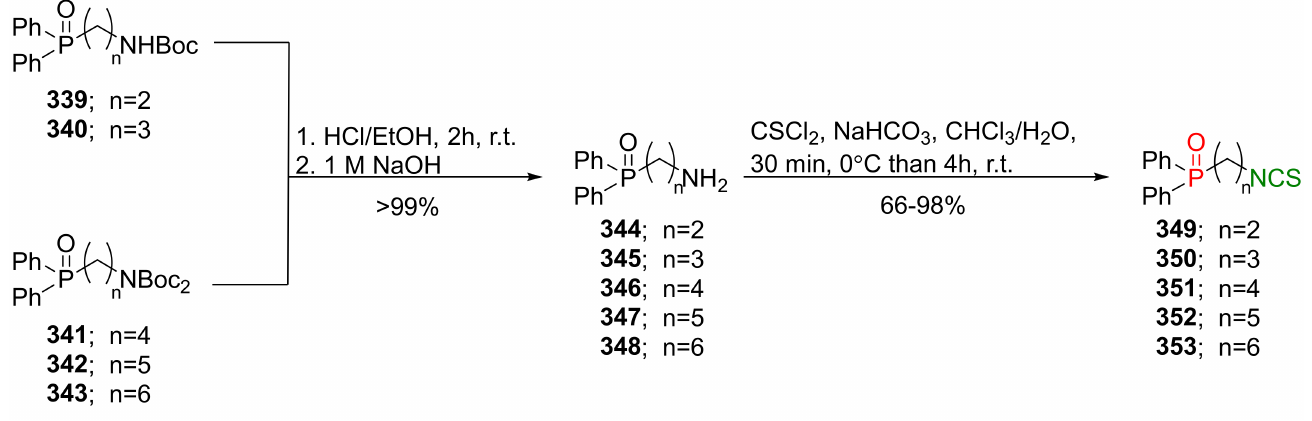
Figure 40. Synthesis of ( ω -isothiocyanatoalkyl)diphenylphosphine oxides 349 – 353